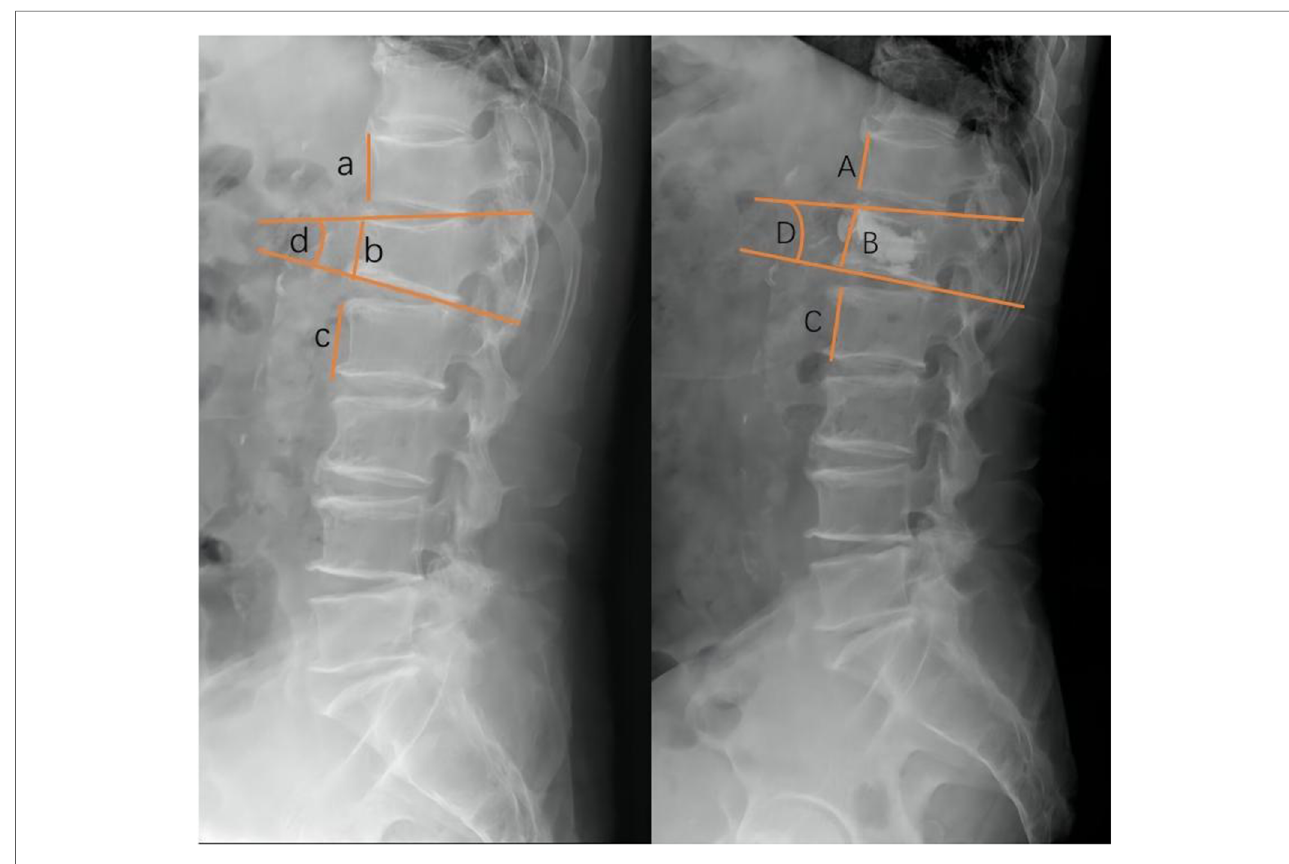
FIGURE 2 Radiographic evaluation of compressed vertebrae. Preoperative VHR (left,%):2b/a+c, VKA (left,°): ∠ d; Postoperative VHR (right,%):2B/A+C, VKA (right,°): ∠ D.